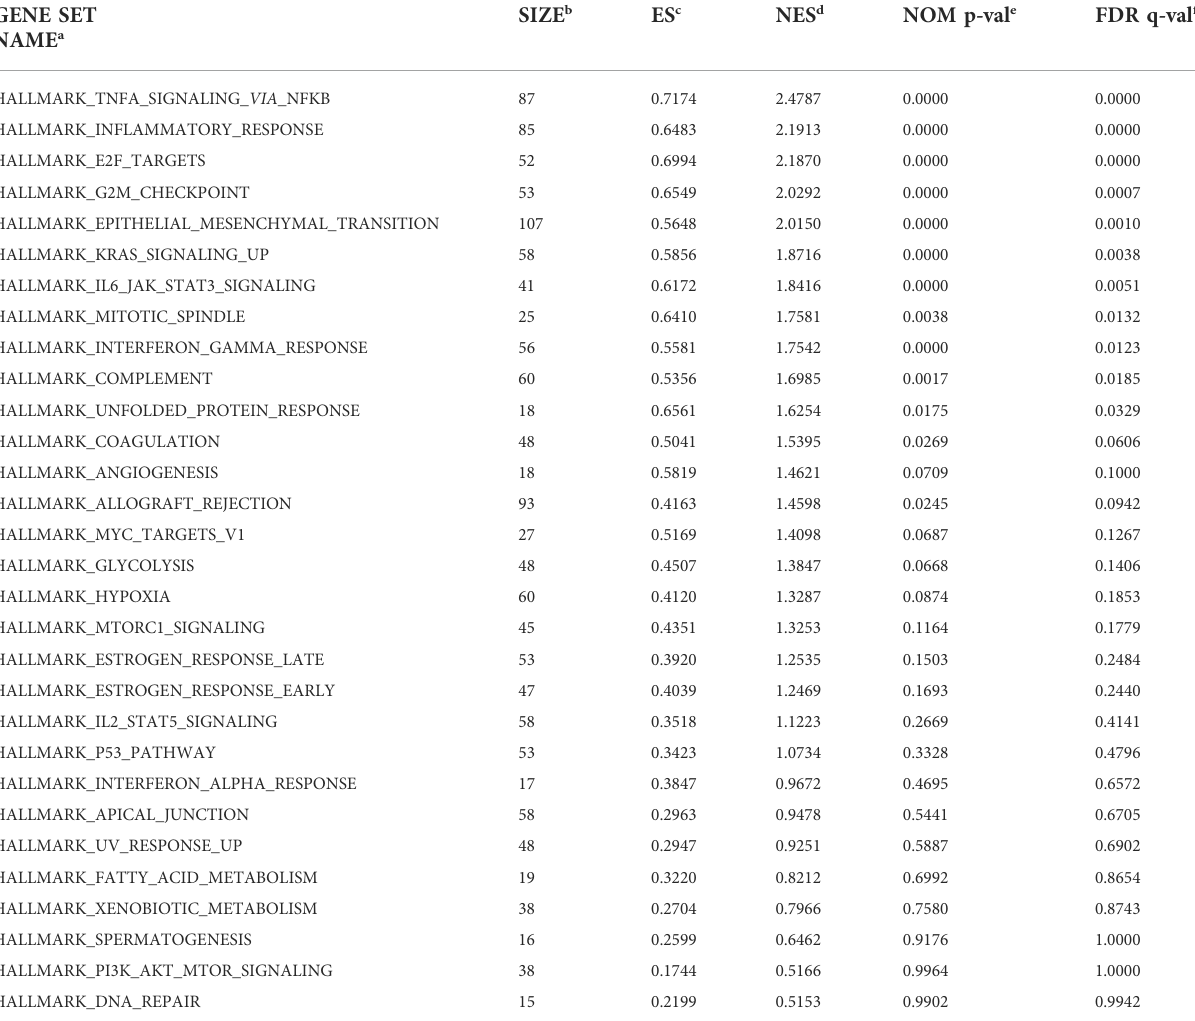
TABLE 1 GSEA results comparing the gene expression pro fi le between ASCs primed or not with IL-1 β using H collection. GENE SET NAME